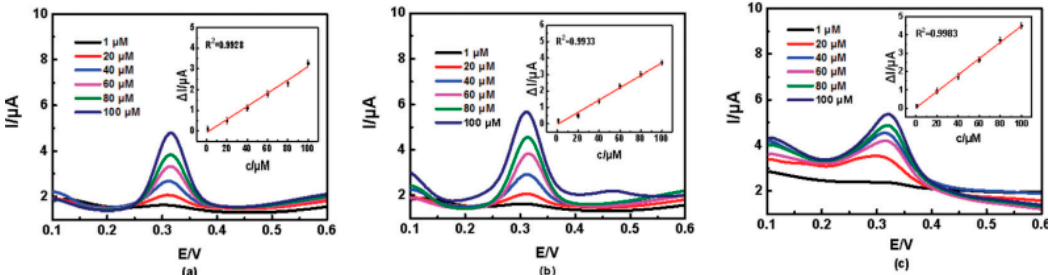
Figure 4. Electrochemical standard curve of the actual samples of ( a ) methyl paraoxon, (b ) methyl parathion and ( c ) ethyl paraoxon with varying concentrations. Reprinted with permission from reference [56]. Copyright 2020 The Royal Society of Chemistry.